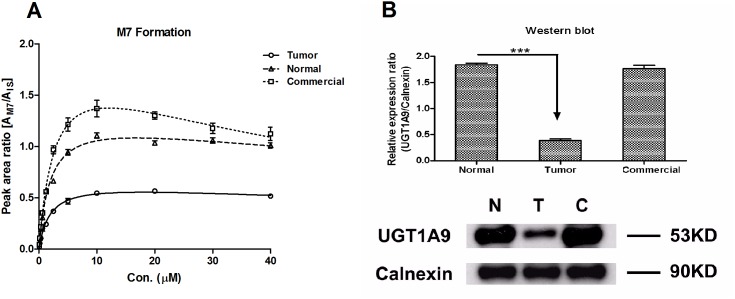
Sorafenib metabolism by UGT1A9 (A) and UGT1A9 protein expression (B) in pooled NHLMs, THLMs and CHLMs.The formation rate of M7 expressed as peak area ratio (mean ± SD). All the experiments were carried out in triplicate. One-way ANOVA, with or without Tukey–Kramer multiple comparison (post-hoc) tests, was used for data analysis. “*” denotes statistical significance (P<0.05); “**” denotes statistical significance (P<0.01), “***” denotes statistical significance (P<0.001).